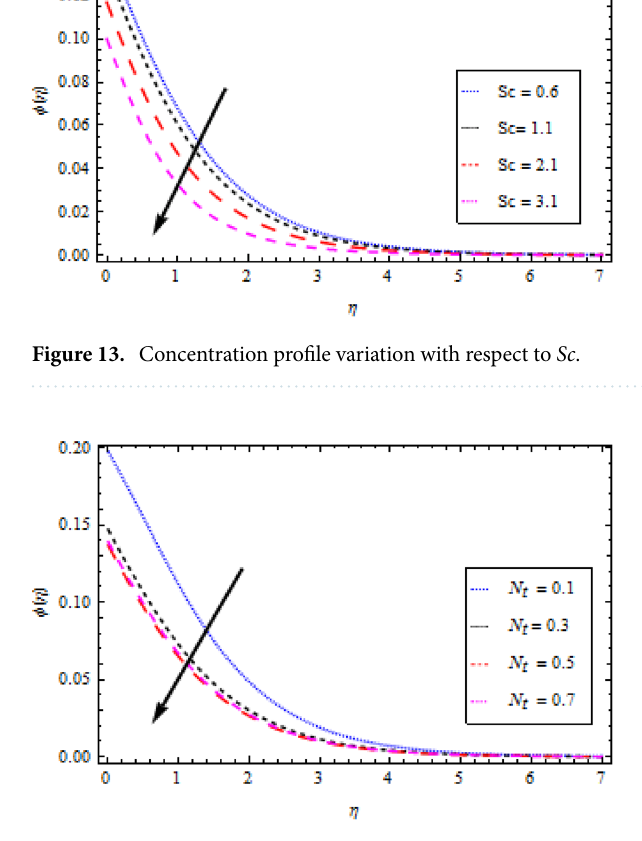
Figure 14. Concentration profile variation with respect to N t .